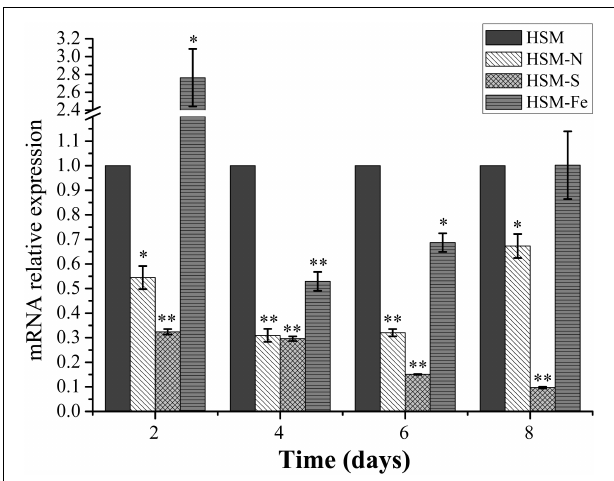
FIGURE 2 | Effects of the deprivation of N, S, and Fe on the expression of CrPrp19 . 18S rRNA was used as an internal control. Expression was normalized to that of untreated HSM groups. Data are means ± SD ( n = 3). Asterisks indicate significant differences at p ≤ 0.05 ( ∗ ) or p ≤ 0.01 ( ∗∗ ) compared with its control by one-way